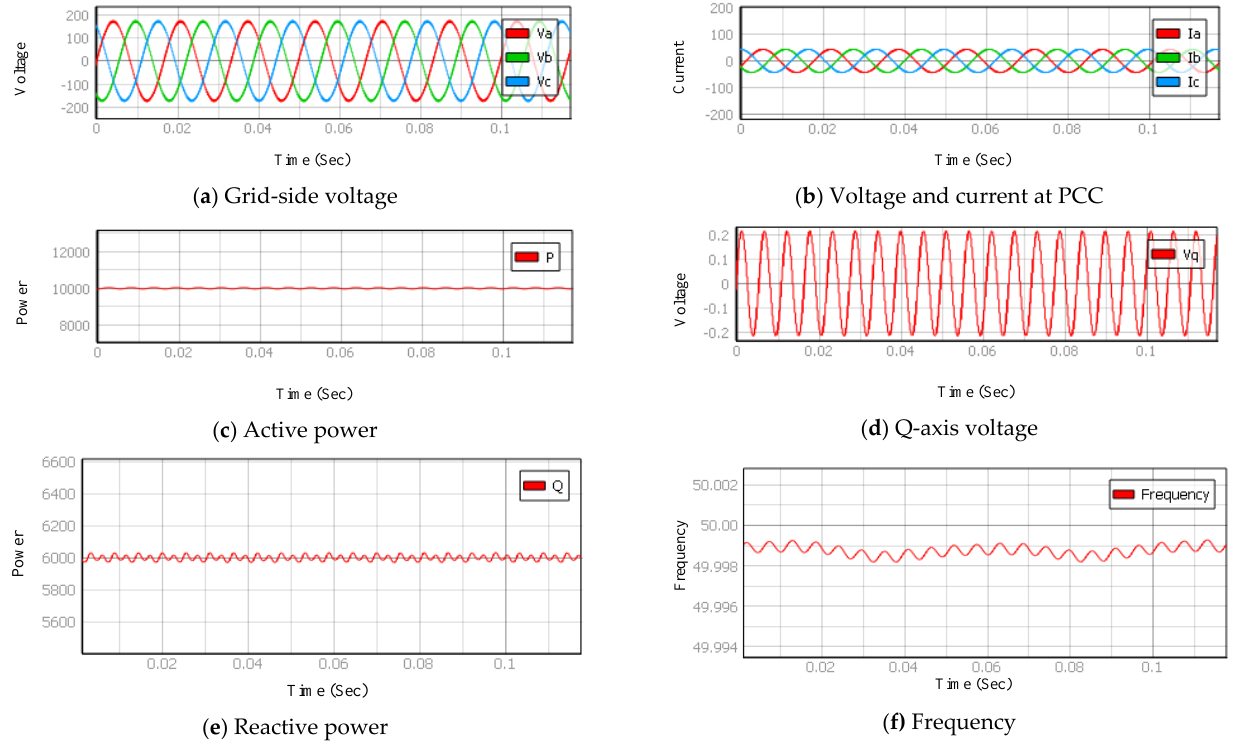
Figure 16. Characteristics of the islanded DG system.